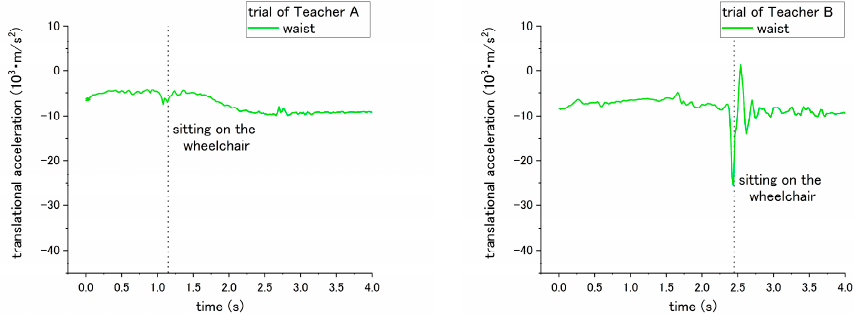
Figure 8. Translational acceleration of patient’s waist during step No. 15 through correct way.